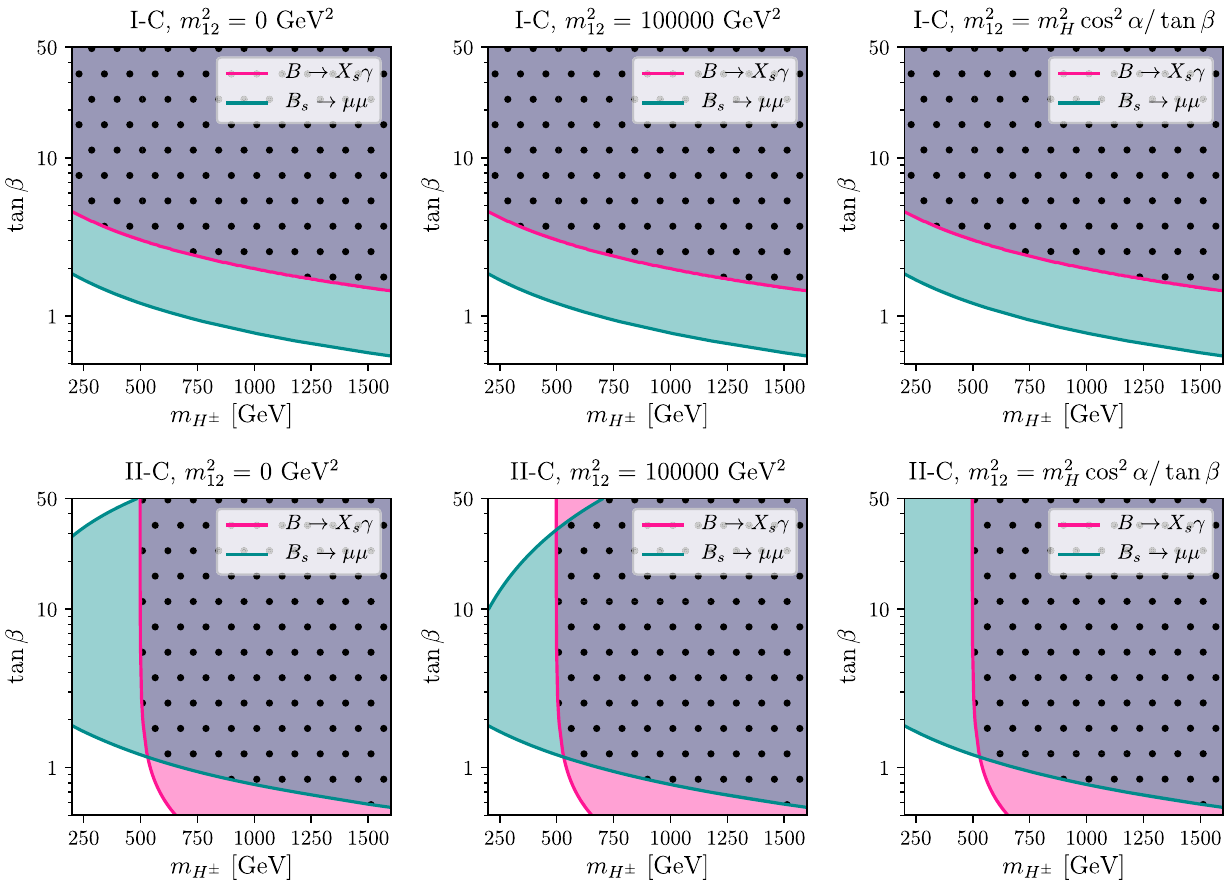
c β − α = 0, has been fixed. Pink areas are the allowed regions by Fig. 7 Allowed regions in the ( m H ± , tan β) plane of the 2HDM for B → X s γ and teal areas those allowed by B s → μ + μ − . scenario C with m H = m A = m H ± and for Yukawa types I (upper row) = 0 , 100000 GeV and set via Eq. (29) in and II (lower row) for m 2 12 the left, middle and right column, respectively. The alignment limit,